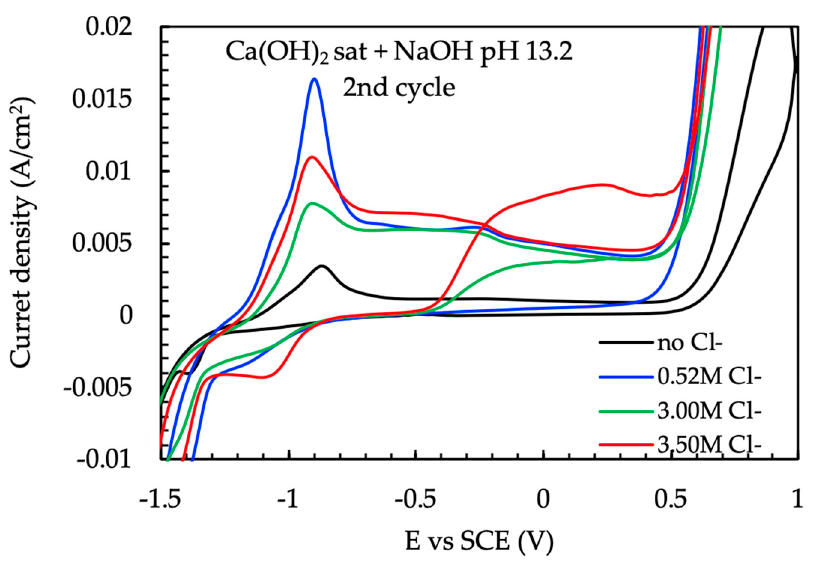
Figure 10. Effect of chloride ions concentration on the second cycle of the voltammetric curves of steel in saturated Ca(OH) 2 solution at pH 13.2 and tartrate ions in a concentration of 1 M.